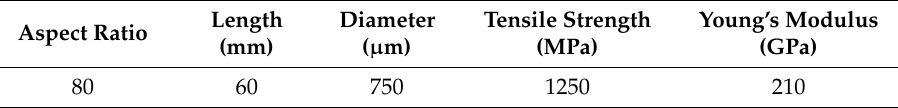
Figure 2. Steel fibers used in this investigation ( a ) typical form ( b ) optical microscope picture. Table 2. Characteristic physico-mechanical properties of steel fibers.